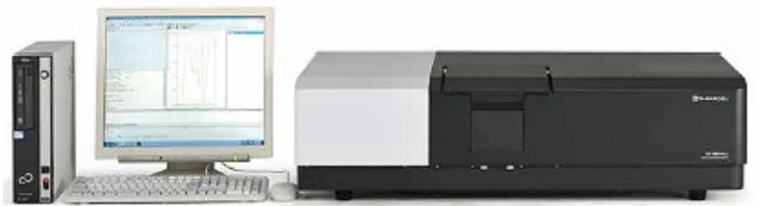
Figure 5. Shimadzu UV3600 UV-Nir NIR spectrometer.